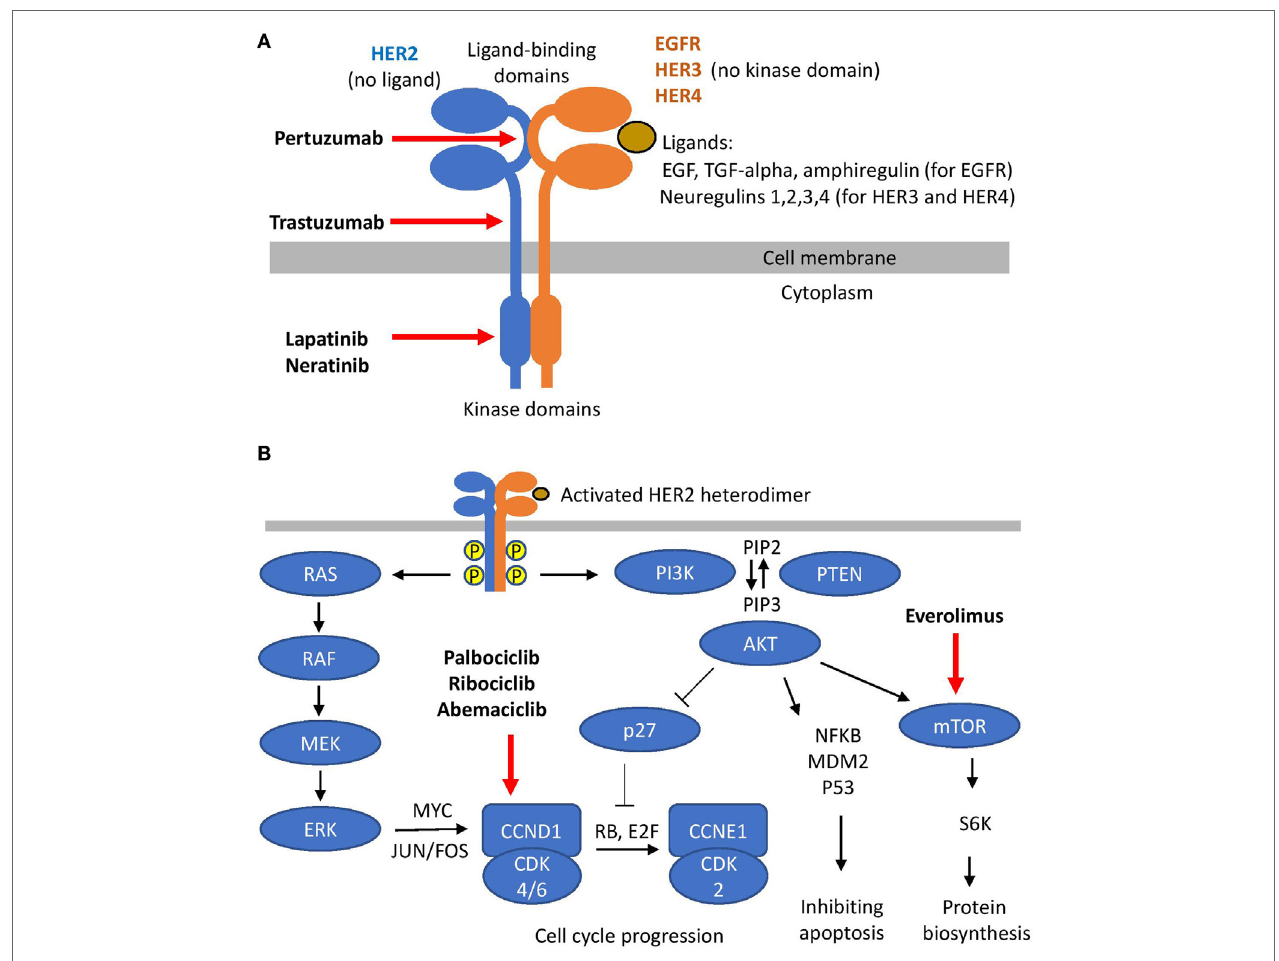
FiGURe 1 | Human epidermal growth factor receptor 2 (HER2) signaling. (A) HER2 hetero-dimerization and HER2 targeting. (B) Signaling downstream of HER2 and its